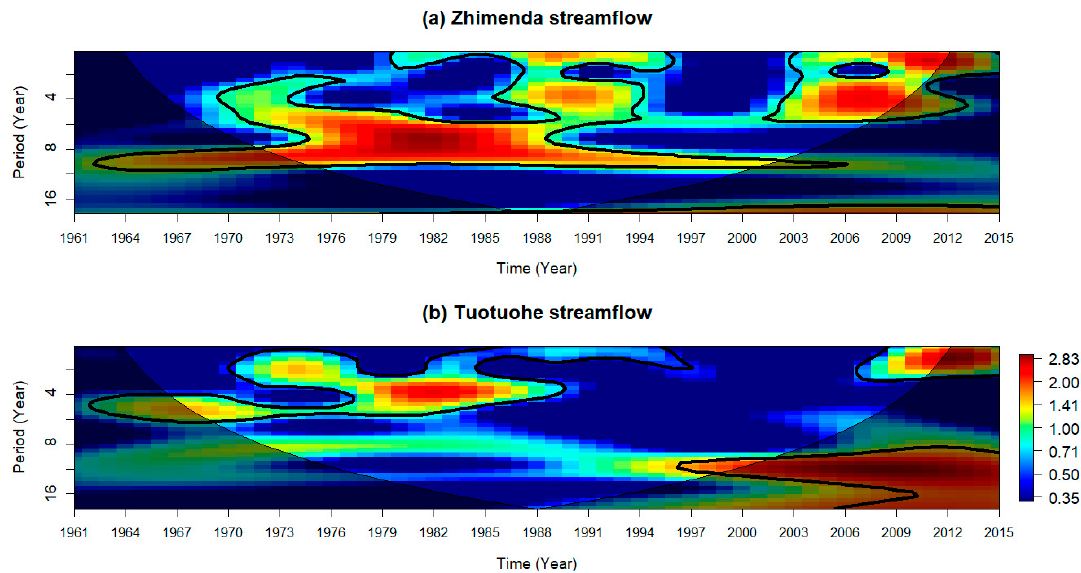
Figure 9. Wavelet power spectrum for streamflow for Zhimenda and Tuotuohe stations during 1961–2015. The black line shows statistical significance at the 0.05 level.